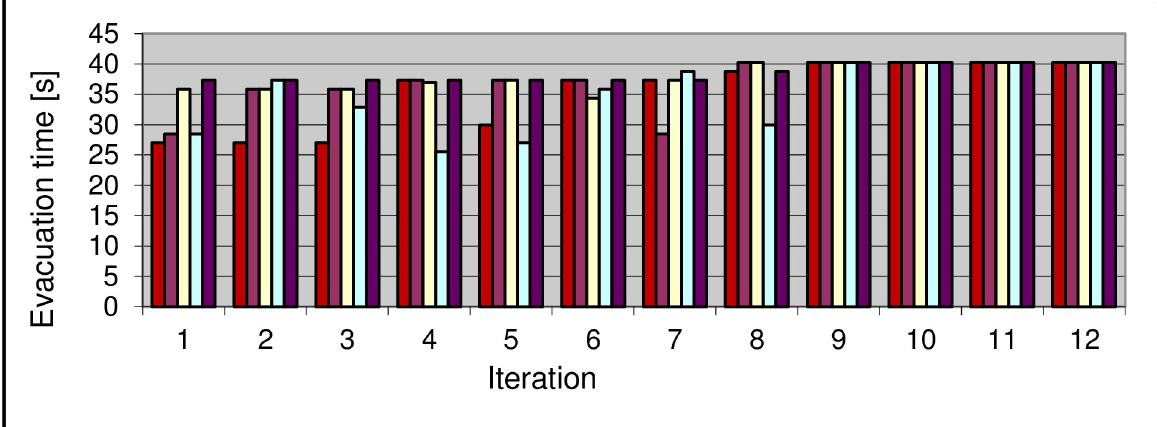
Fig 4. Evacuation time obtained in each iteration using genetic algorithm